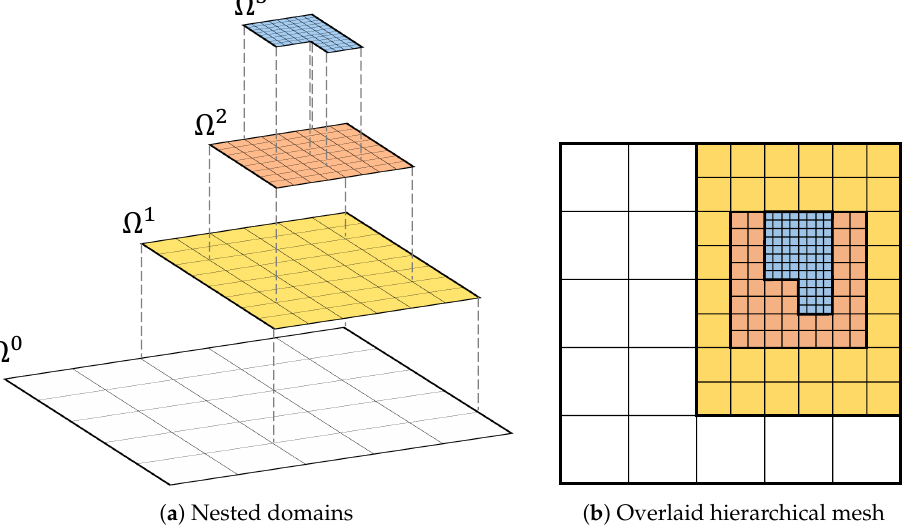
Figure 7. A two-dimensional four-level dyadic hierarchical mesh: ( a ) the nested domains contain level-wise sub-meshes; ( b ) the sub-meshes are overlaid to generate the hierarchical mesh. The hierarchical B-spline basis H is defined